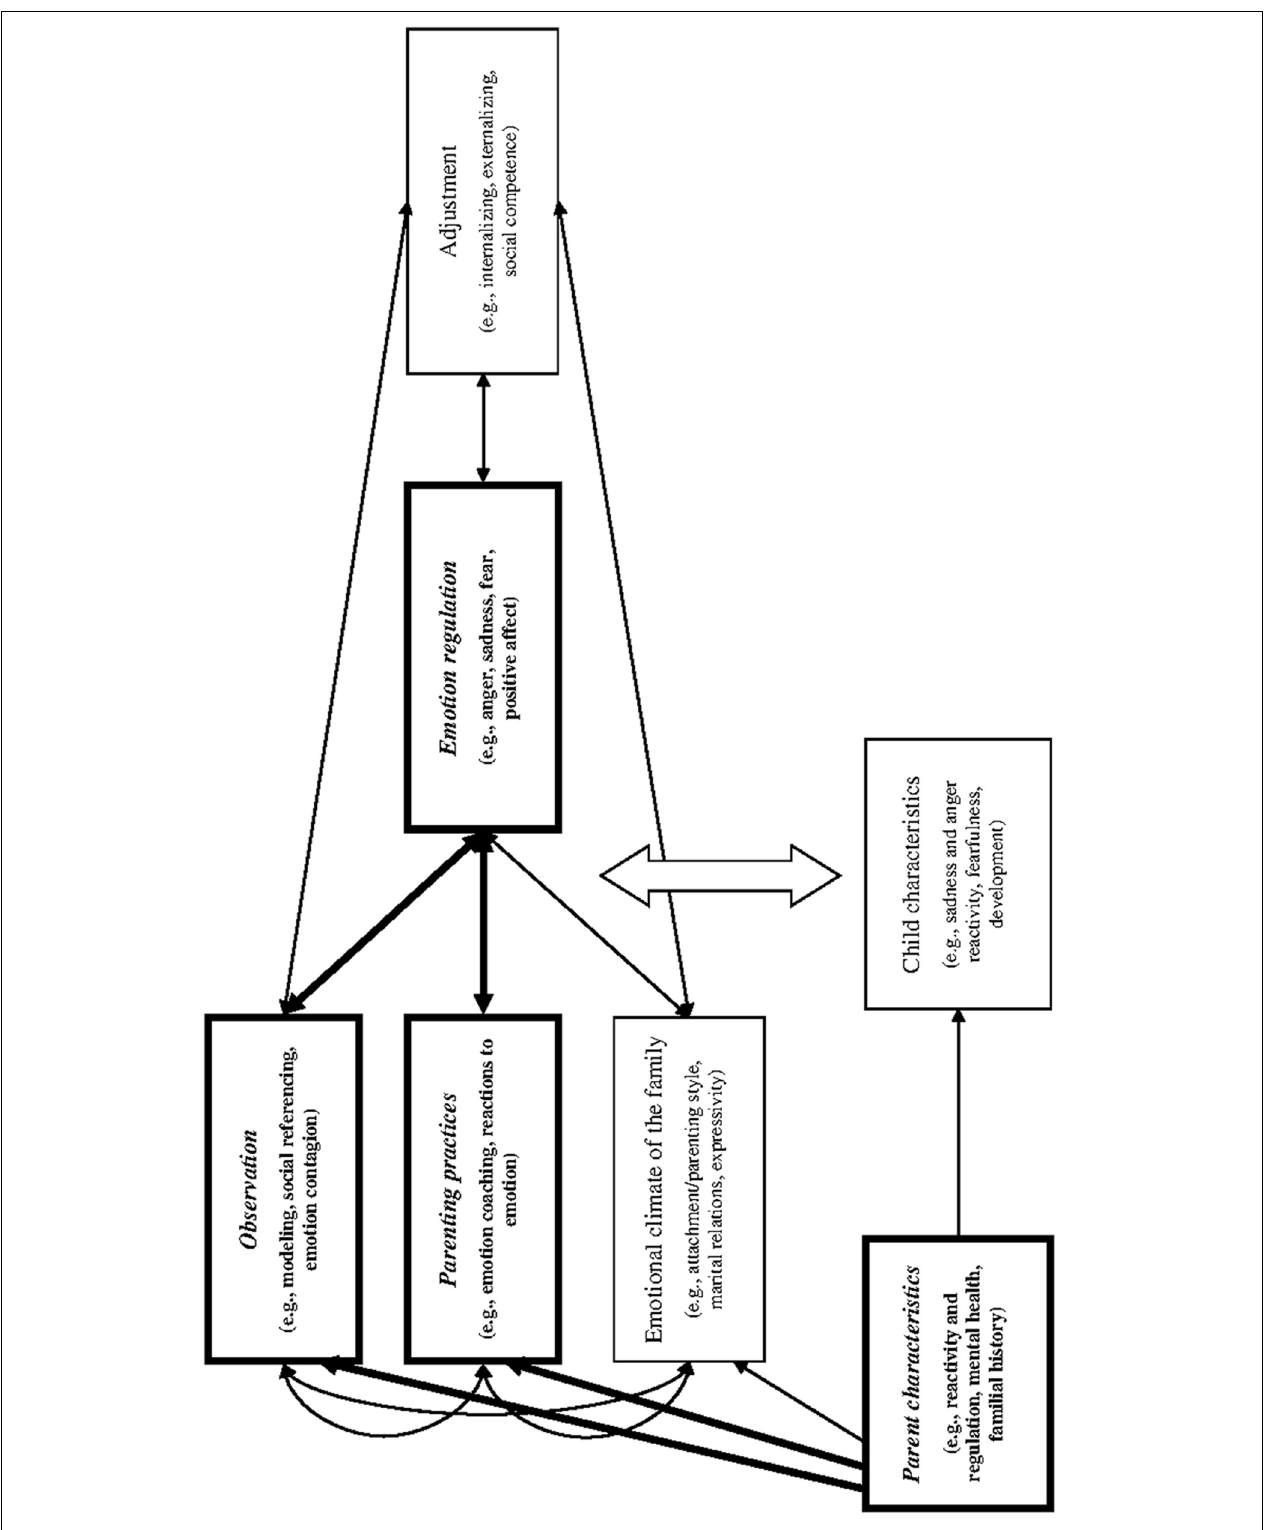
FIGURE 1 | The Tripartite model of family impact on children’s emotion regulation and adjustment. Figure adapted from Morris et al. (2007, p. 362). The parts of the model investigated in the present study are printed bold.